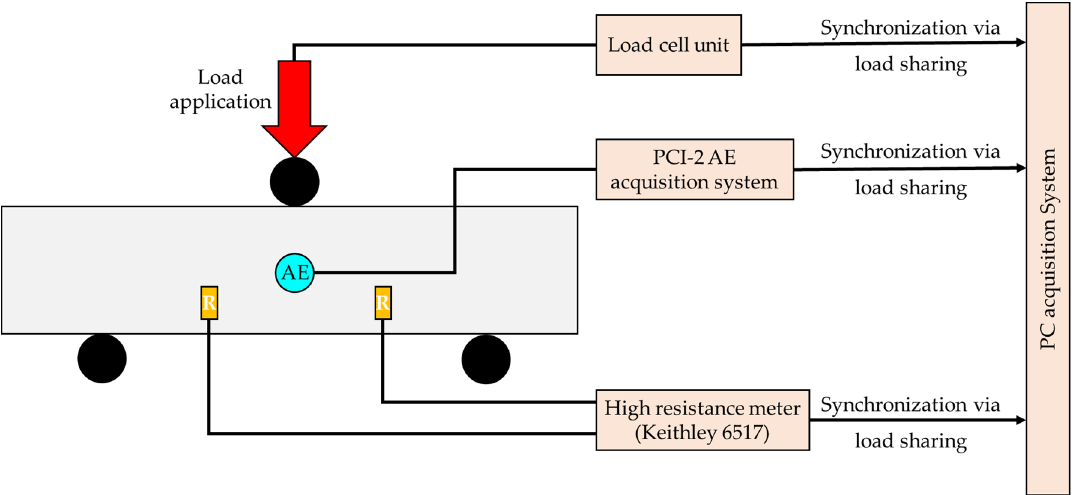
Figure 1. The experimental setup for the concurrent recordings of the electrical resistance and the AEs during the presented 3PB tests. AEs during the presented 3PB